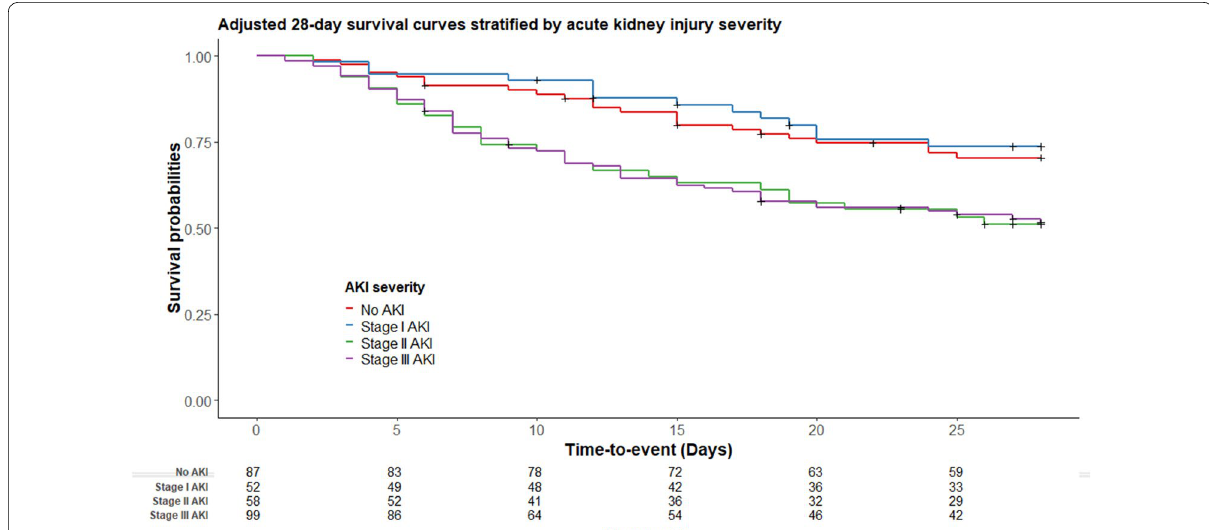
Fig. 3 Adjusted 28‑day survival curves stratified by severity of acute kidney injury (adjusted for PaO 2 :FiO 2 on day 1, APACHE III score, and septic